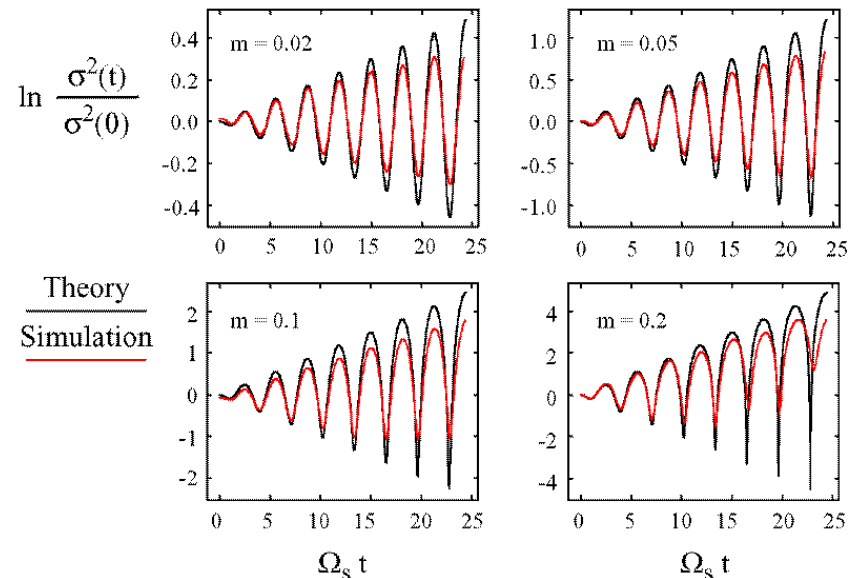
FIG. 6. (Color) Comparison between theoretical result [Eq. (18)] and